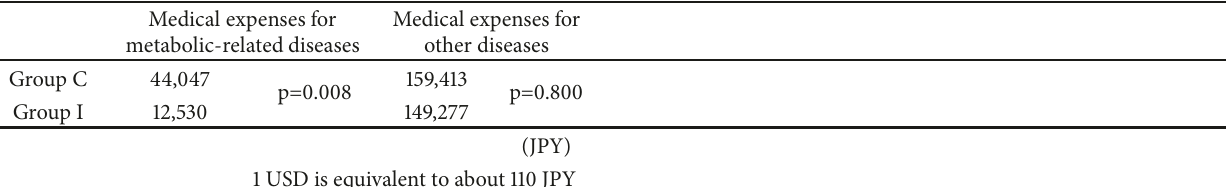
Table 4: Comparison of medical expenses for metabolic-related and other diseases for 26 months.